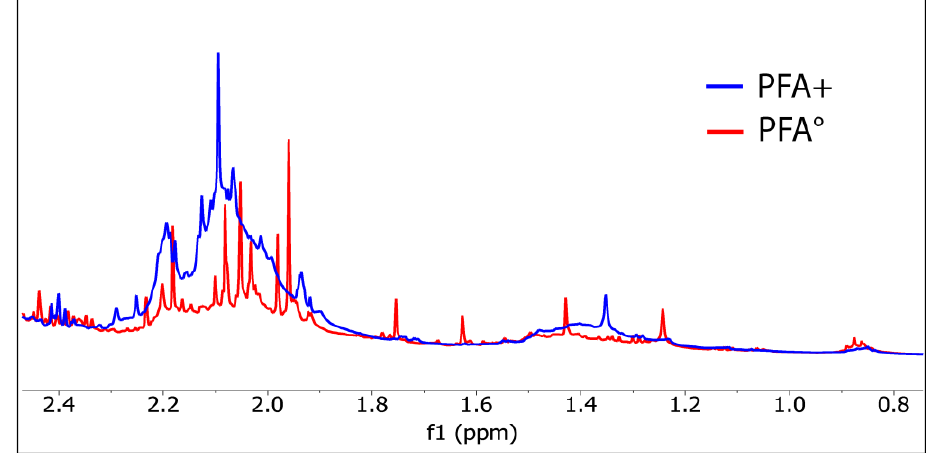
Figure 2. Magnified 1H NMR spectra of PFA° (red) and PFA+ (blue) at a conversion degree of about 0.80.